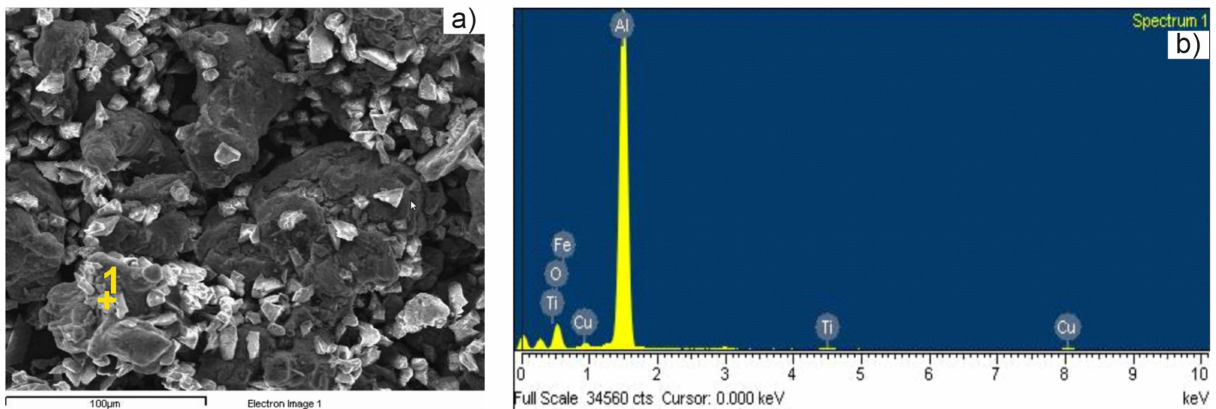
Figure 3. Alumixpowders: ( a )SEMimageand( b